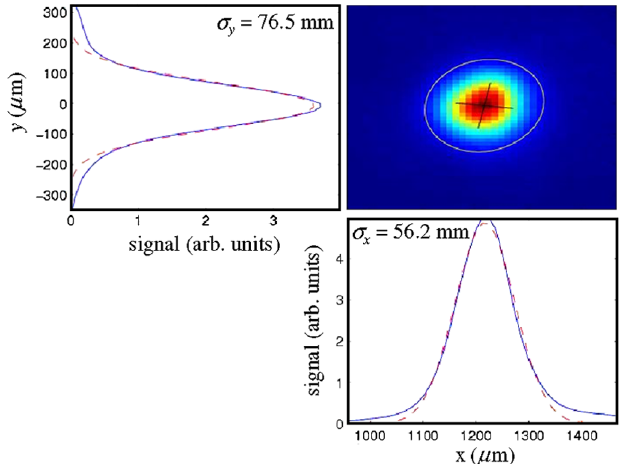
FIG. 21. (Color) Measured beam profile in both planes on the ‘‘OTR2’’ screen (2nd OTR in Fig. 1) at 135 MeV with 56 (cid:2) m and 76 (cid:2) m rms sizes in x and y , respectively. Gaussian profiles (red-dashed) with the same rms are overlaid here for convenient comparison.